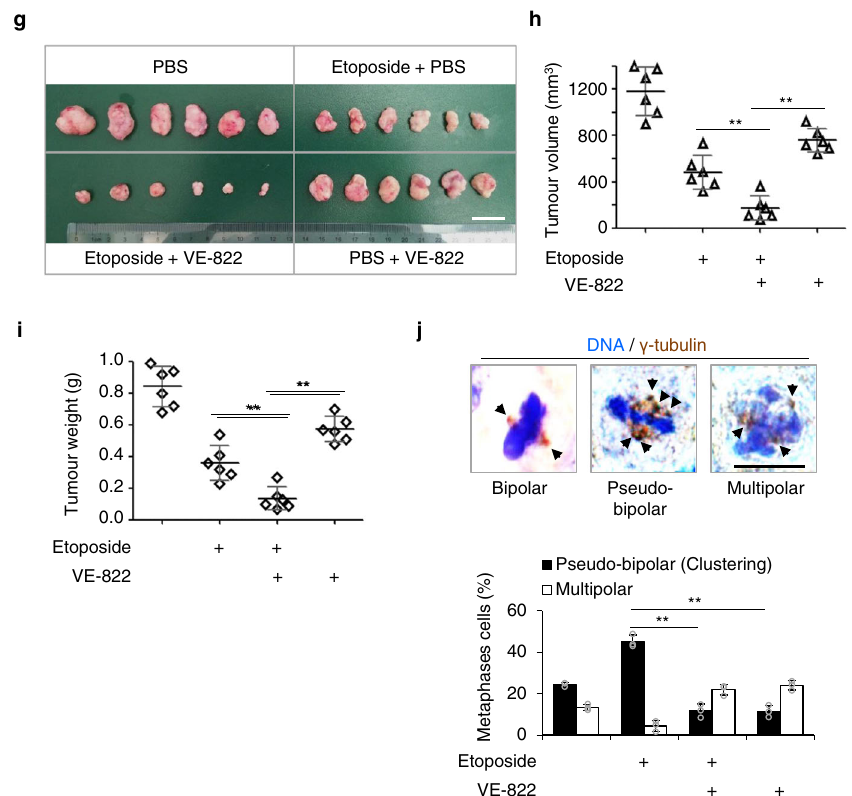
Fig. 6 KIFC1-S26 phosphorylation induces drug resistance. a, c – f KIFC1-S26 phosphorylation induces etoposide resistance. b, g – j Etoposide-resistance is restrained by ATM/ATR inhibitor VE-822. a, b The indicated stable cell lines were treated with etoposide (0.5 μ M) or VE-822 (5 μ M) for 4 days, and then were analyzed for cell viability using the MTT assay. Histogram graphs showing the percentage of surviving cells. a Two-tailed t test p values (from left to right): p = 0.0007, 0.0099, and 0.0090. b Two-tailed t test p values (from left to right): p = 0.0005, 0.0110, and 0.0143. c, g Xenograft experiment with KIFC1-WT, S26A, or S26D stable cells was described in the Methods section. Tumors were collected and photographed (scale bar, 2cm). d, e, h , i Quanti fi cation of average tumor volume ( d, h ) and weight ( e, i ). Six tumors were included in each group. d Two-tailed t test p values (from left to right): p = 0.0062 and 0.00001. ( e ) Two-tailed t test p values: p = 0.0099 and 0.00001. h Two-tailed t test p values: p = 0.0053 and 0.0016. i Two-tailed t test p values: p = 0.0057 and 0.0016. f, j Representative immunohistochemical images showing γ -tubulin staining (scale bar, 10 μ m) with quantitative analysis of pseudo-bipolar (centrosome clustering) and multipolar mitosis of the tumor sections of xenograft tumor samples after treatment with etoposide or VE-822. Arrows point to the centrosomes. For each experimental condition, 100 – 161 cells were counted, and three independent experiments were performed. f Two-tailed t test p values: p = 0.0016, 0.9245, and 0.5663. j Two-tailed t test p values: p = 0.0006 and 0.0092. Data represent the mean±SD of three times of independent experiments. NS = not signi fi cant, * p <0.05, ** p <0.01, Source data are provided as a Source Data fi